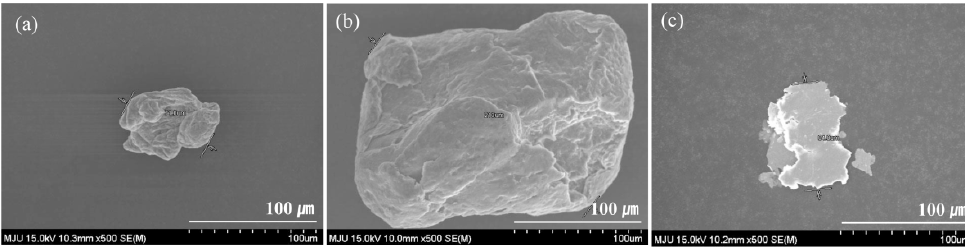
Figure 2. SEM images of three inorganic crystal fillers: ( a ) aluminum; ( b ) magnesium; ( c ) copper.